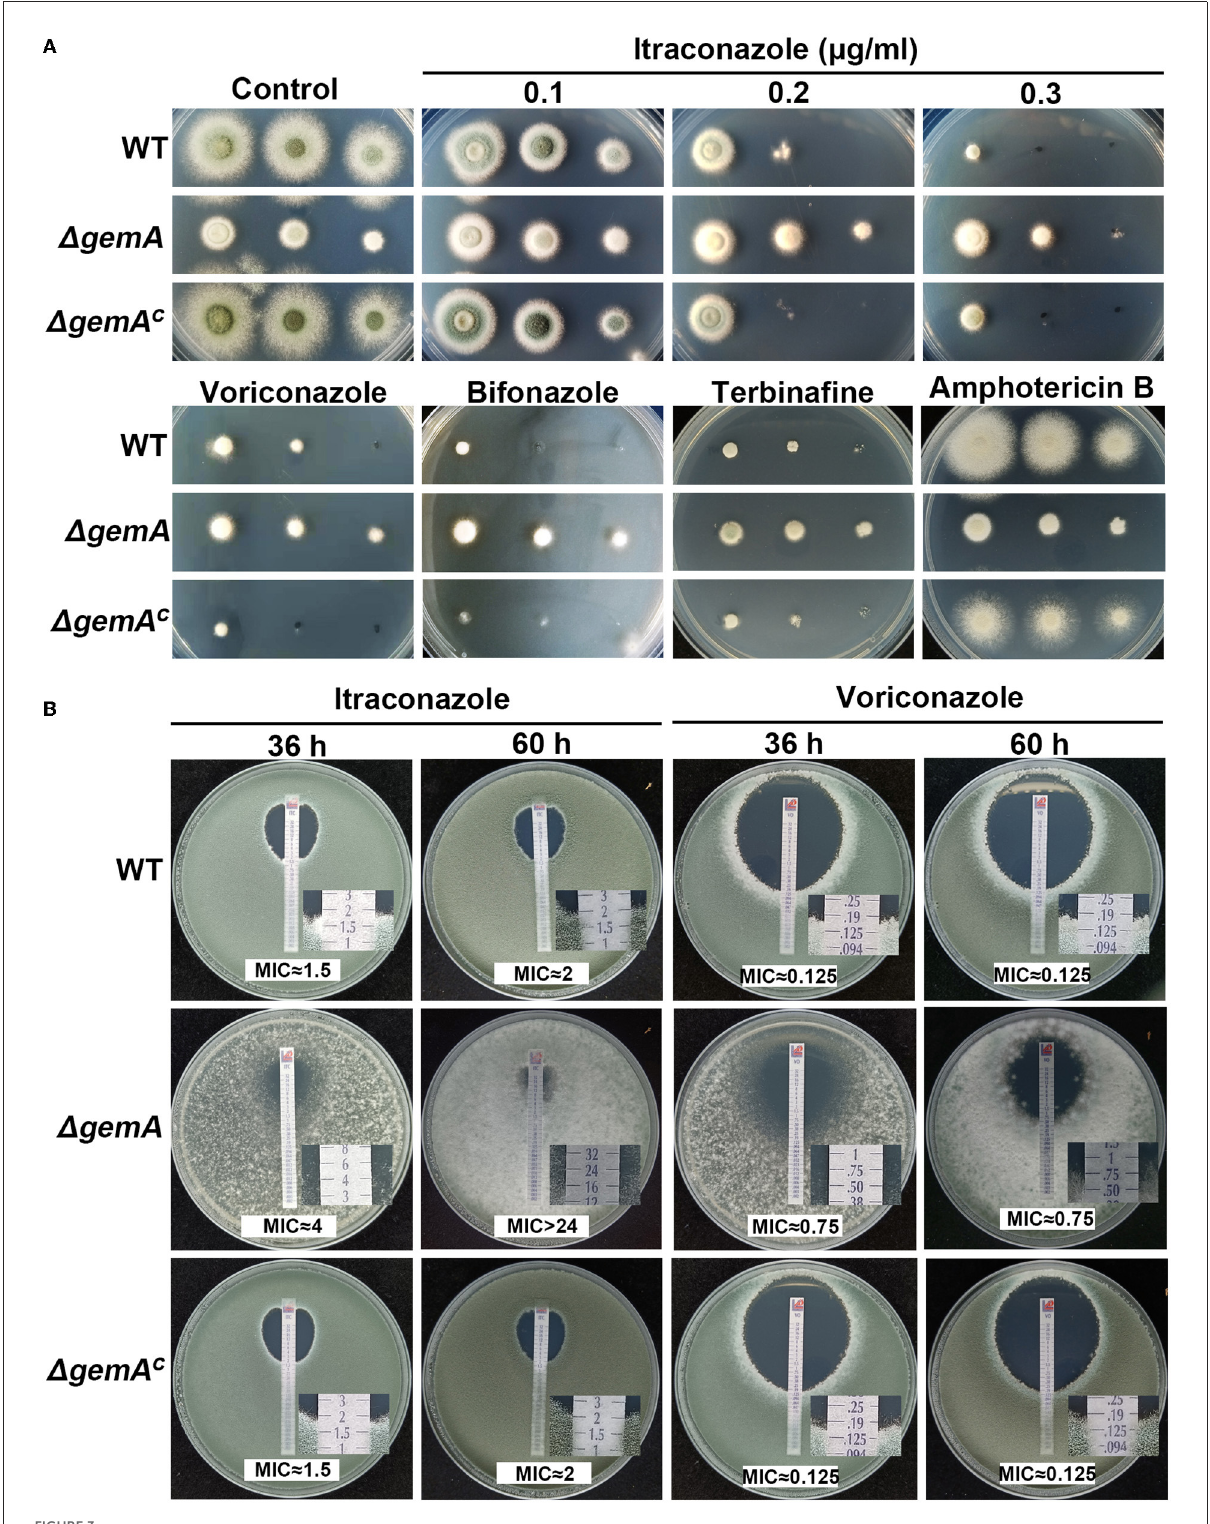
FIGURE3 Loss of GemA increased resistance to azoles. (A) Colony morphologies of the indicated strains cultured in MM supplemented with itraconazole (ITC; 0.1, 0.2, and 0.3 µ g/mL), voriconazole (0.3 µ g/mL), bifonazole (0.7 µ g/mL), terbinafine (0.6 µ g/mL), and amphotericin B (6 µ g/mL) at 37 ◦ C for 2 days. (B) The MIC test of the related strains was conducted using the commercialized E -test strip. Conidia (1 × 10 5 ) of the WT or 1 gemA were mixed in YAG, and then, the ITC or voriconazole test strip was placed on the plate and incubated at 37 ◦ C for 36h or